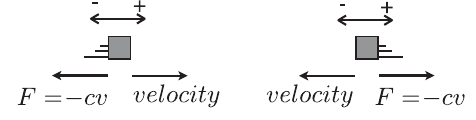
FIG. 3. Drag forces on a moving block.